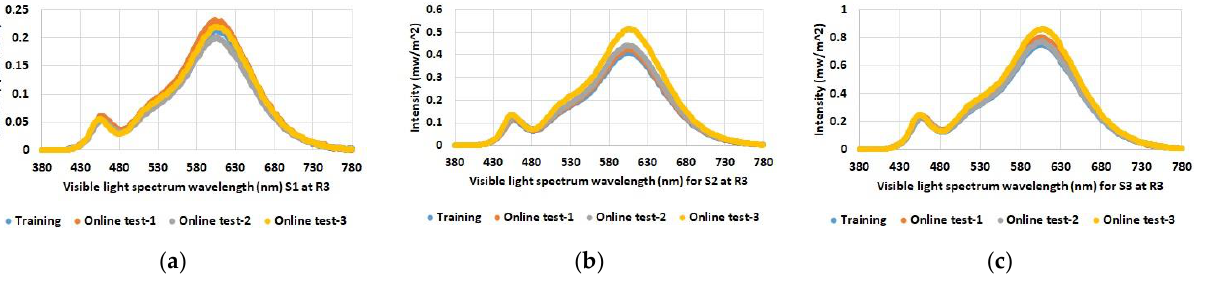
Figure 7. Determined spectral light distribution at defined spectrum test points in room 3: ( a ) S1; ( b ) S2; ( c ) S3. Table 13. Results for an additional experiment with walking activity in room 1 and direct